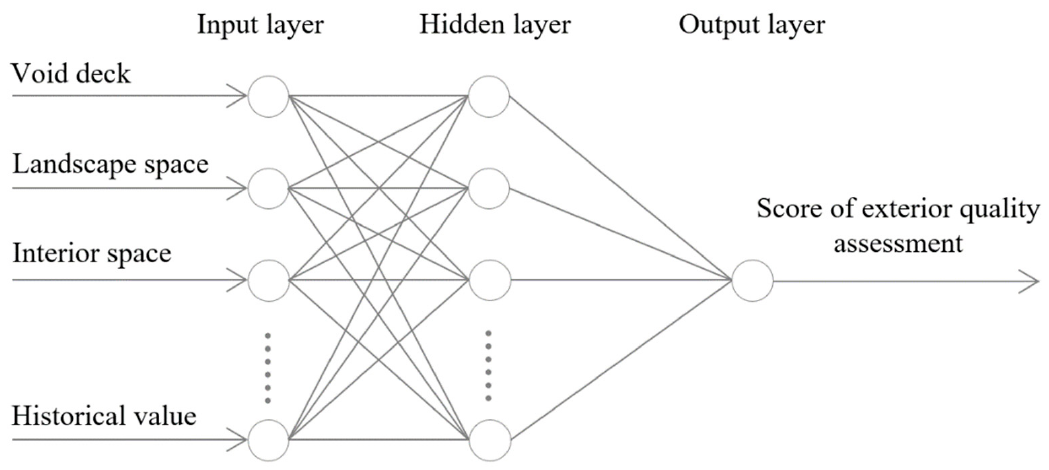
Figure 4. BP neural network structure for the exterior quality assessment.